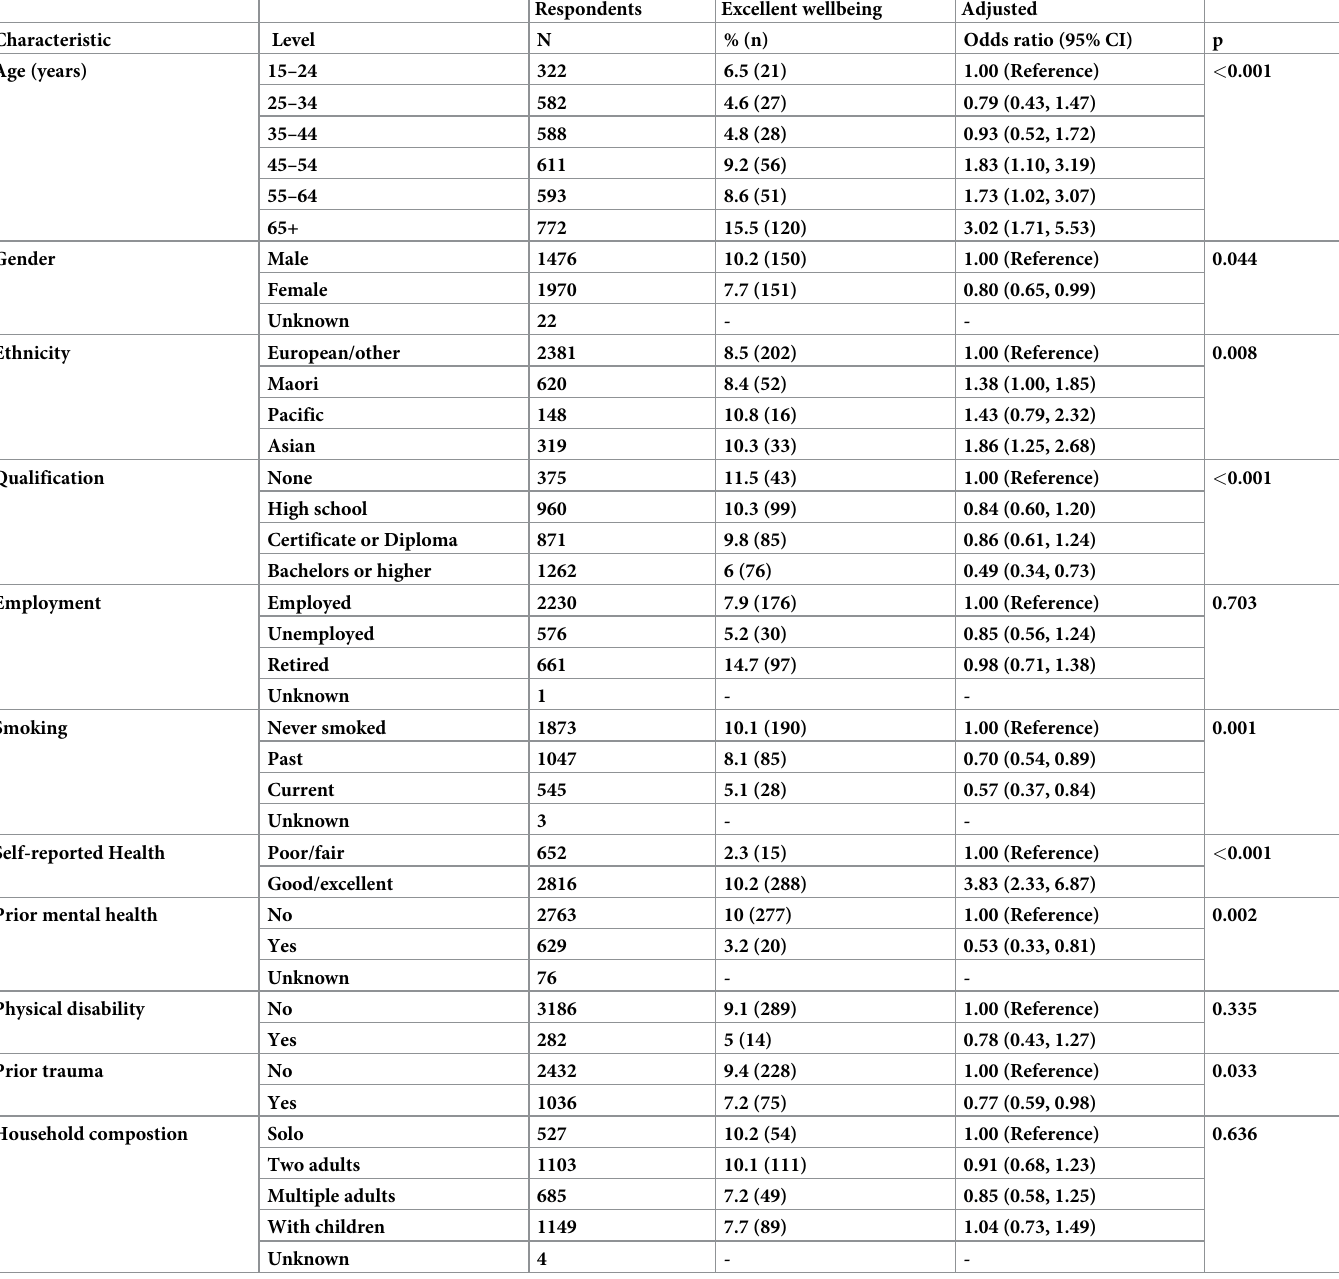
Table 1. Multivariable modelling of independent variables and excellent